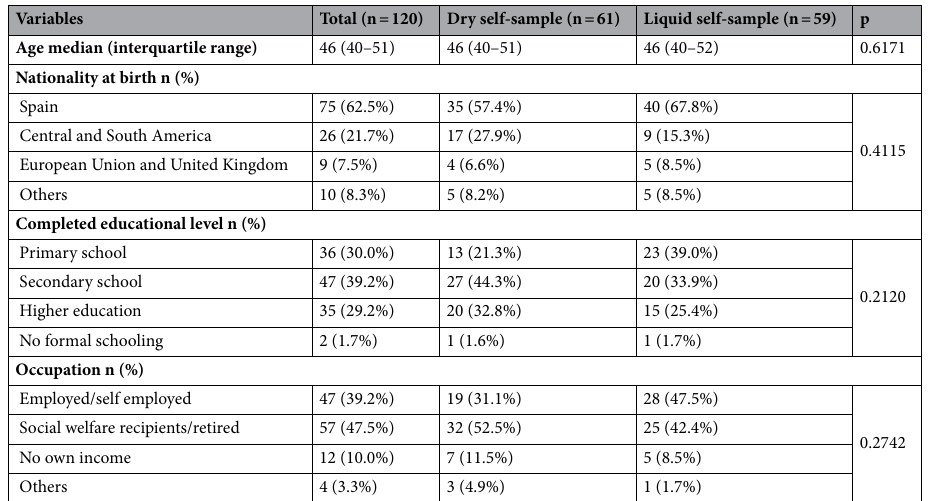
Table 2. Socio-demographic characteristics of the